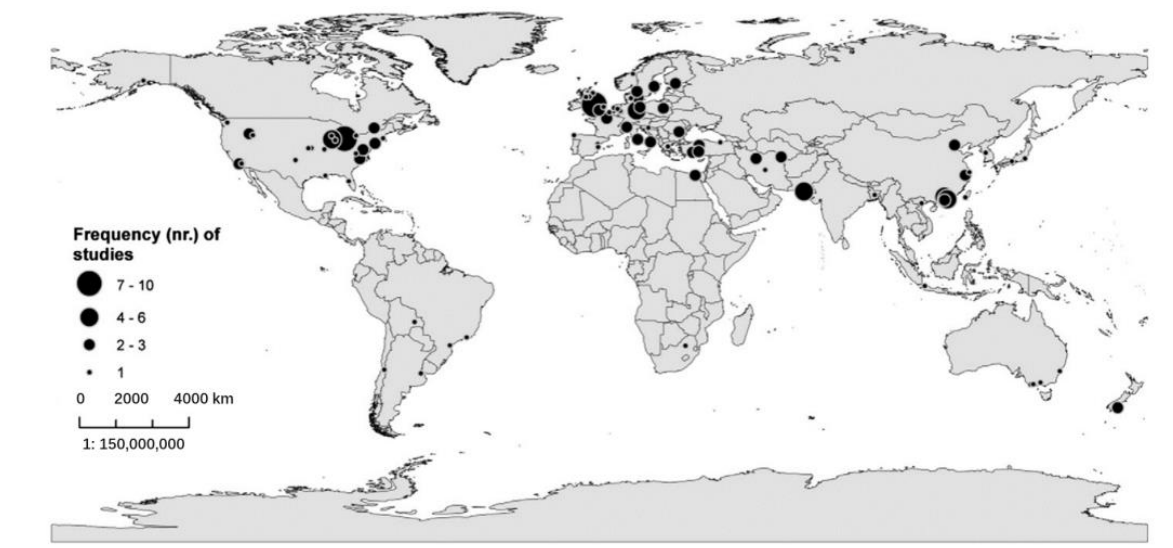
Figure 3. Regional distribution of case studies of this review. Note: Regions are defined by the number of cases identified in them.